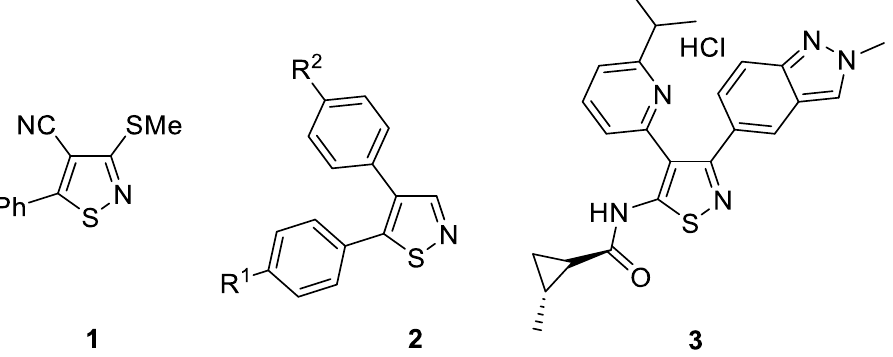
Figure 1. Biologically active aryl- and hetaryl-substituted isothiazoles.